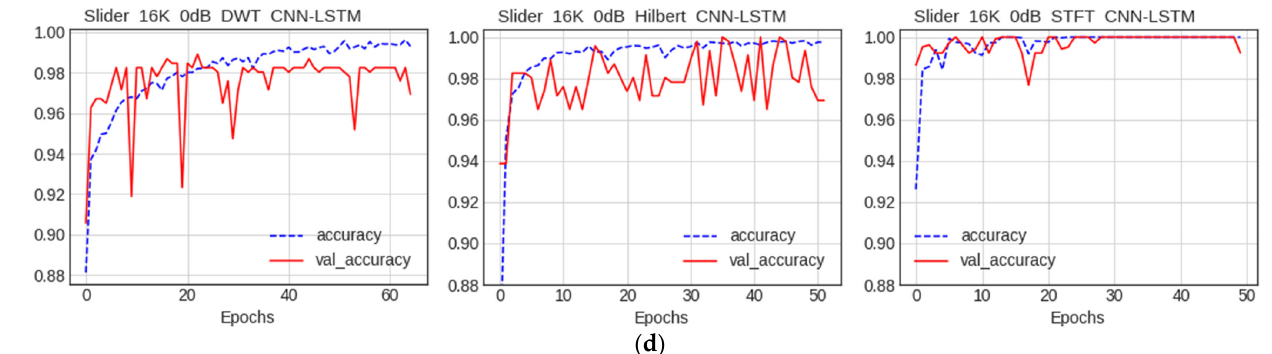
Figure 16. Accuracy of using data after preprocessing with DWT, Hilbert transform, and the STFT: ( a ) results of training valve data on CNN model; ( b ) results of training valve data on the CNN–LSTM model; ( c ) results of training slider data on CNN model; and ( d ) results of training slider data on the CNN–LSTM model.